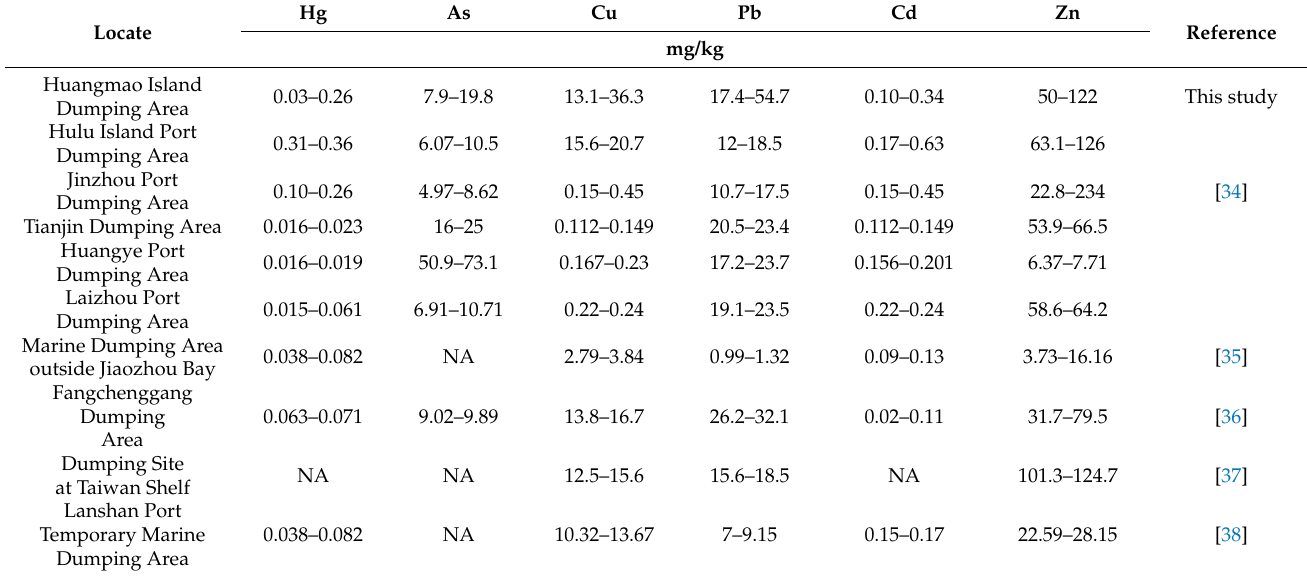
Table 2. The concentrations of HMs in sediments from other dumping